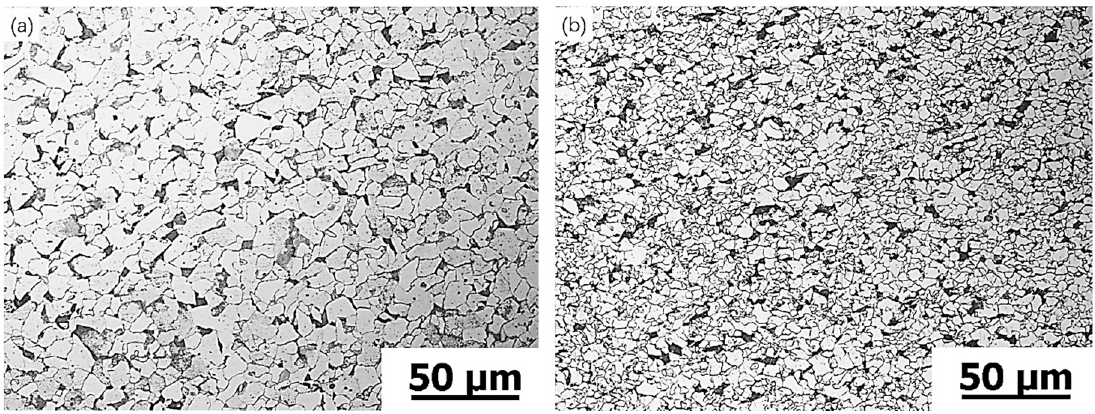
Figure 10. Optical micrographs of rolling samples with different alloy addition sequences: ( a ) Al–Ti–Mg; and ( b ) Al–Mg–Ti.